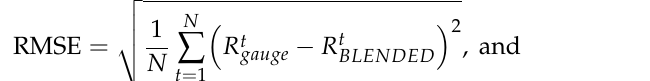
Figure 2 . Boundary of the Seoul metropolitan area for which quantitative precipitation forecasts (QPFs) were obtained, locations of Korea Meteorological Administration’ (KMA’s) automatic weather stations (AWS), and boundaries of the Gangnam and Bakwoon basins studied in detail.